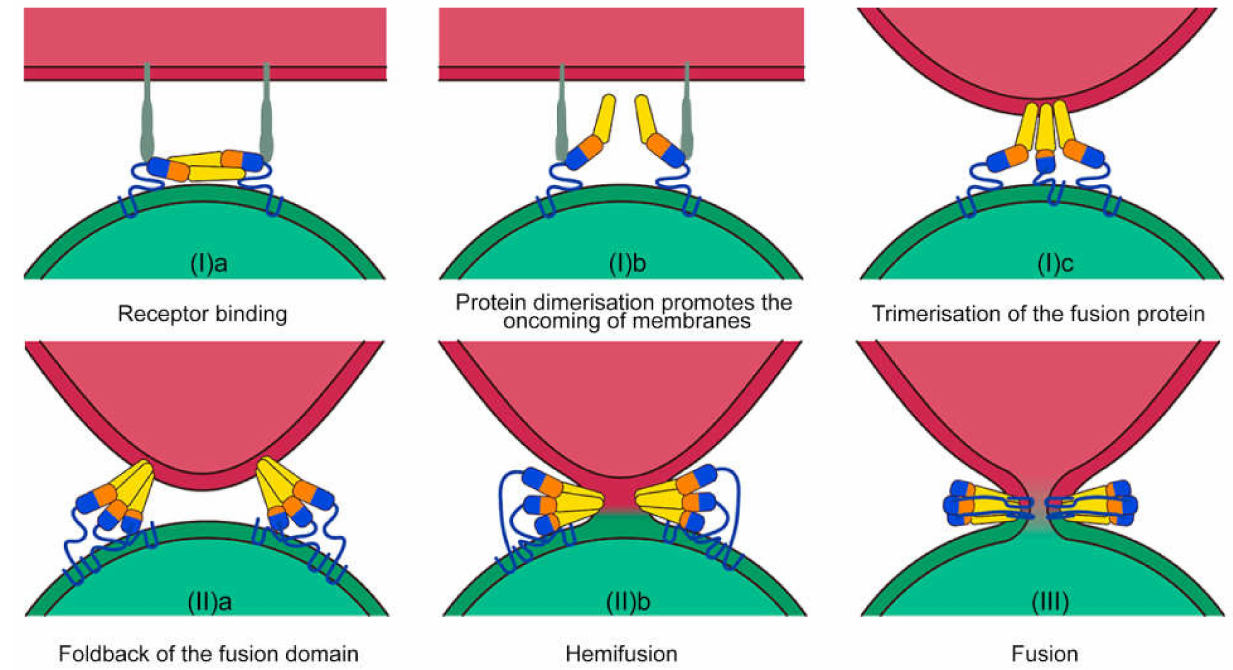
Figure 1. Molecular mechanisms of membrane fusion. Fusion proteins (shown in multicolor monomers) in viral particles (shown in green) recognize the target molecule (shown in grey) on the cell surface (shown in red). A change in the conformation of fusion proteins is required for pore formation. This process includes several stages: membrane recognition ( Ia ), docking ( Ib ) and trimerization ( Ic ), membrane approaching ( IIa ), deformation, destabilization ( IIb ), and fusion pore formation ( III ) and its growth. The latter leads to the merging of the two